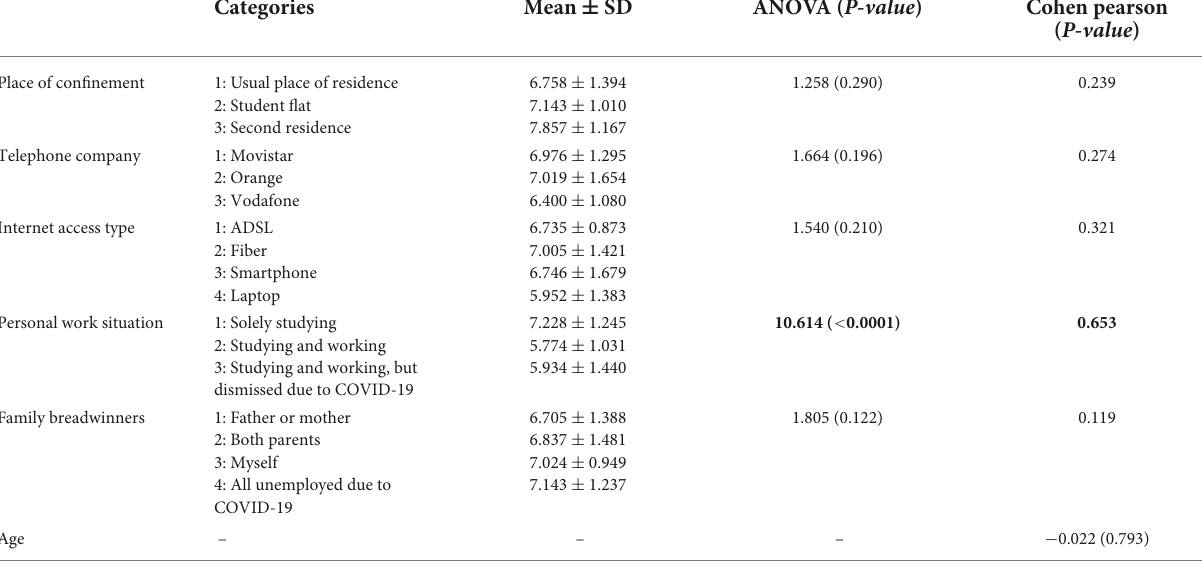
TABLE 2 Measures of association and difference between categories for the study variables and academic results.